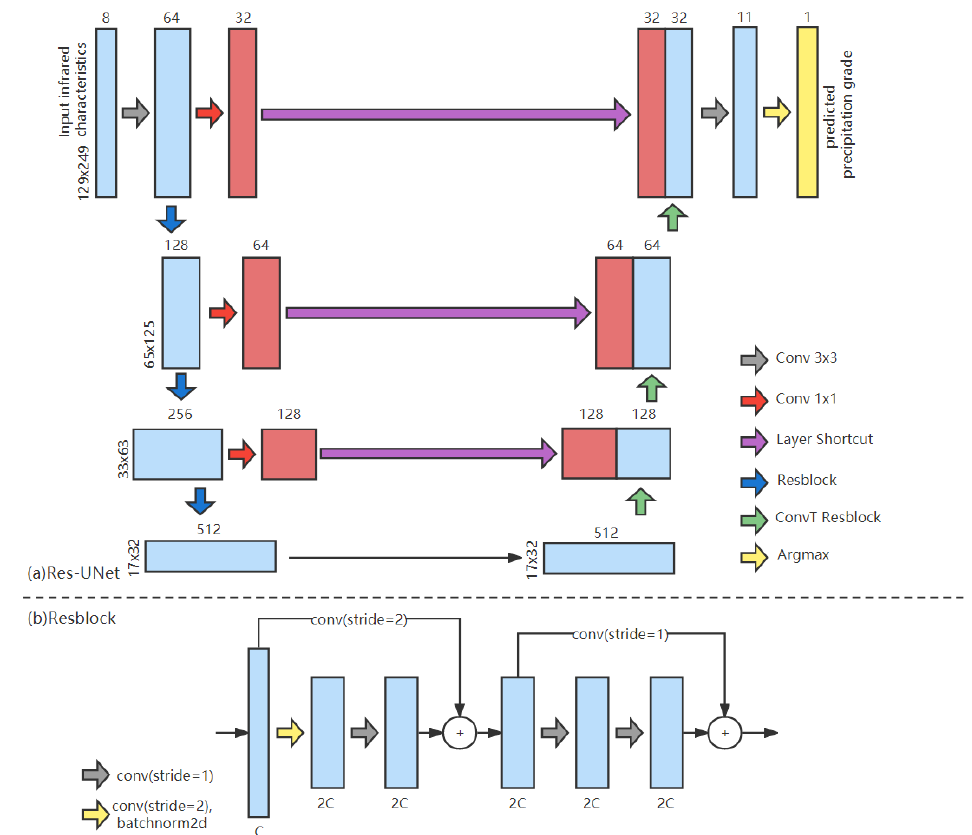
Figure 4. Construction of Res-UNet and Resblock. ( a ) Network construction of Res-UNet as semantic segmentation network in PrecipGradeNet. ( b ) Construction of Resblock; C refers to the number of input channels.